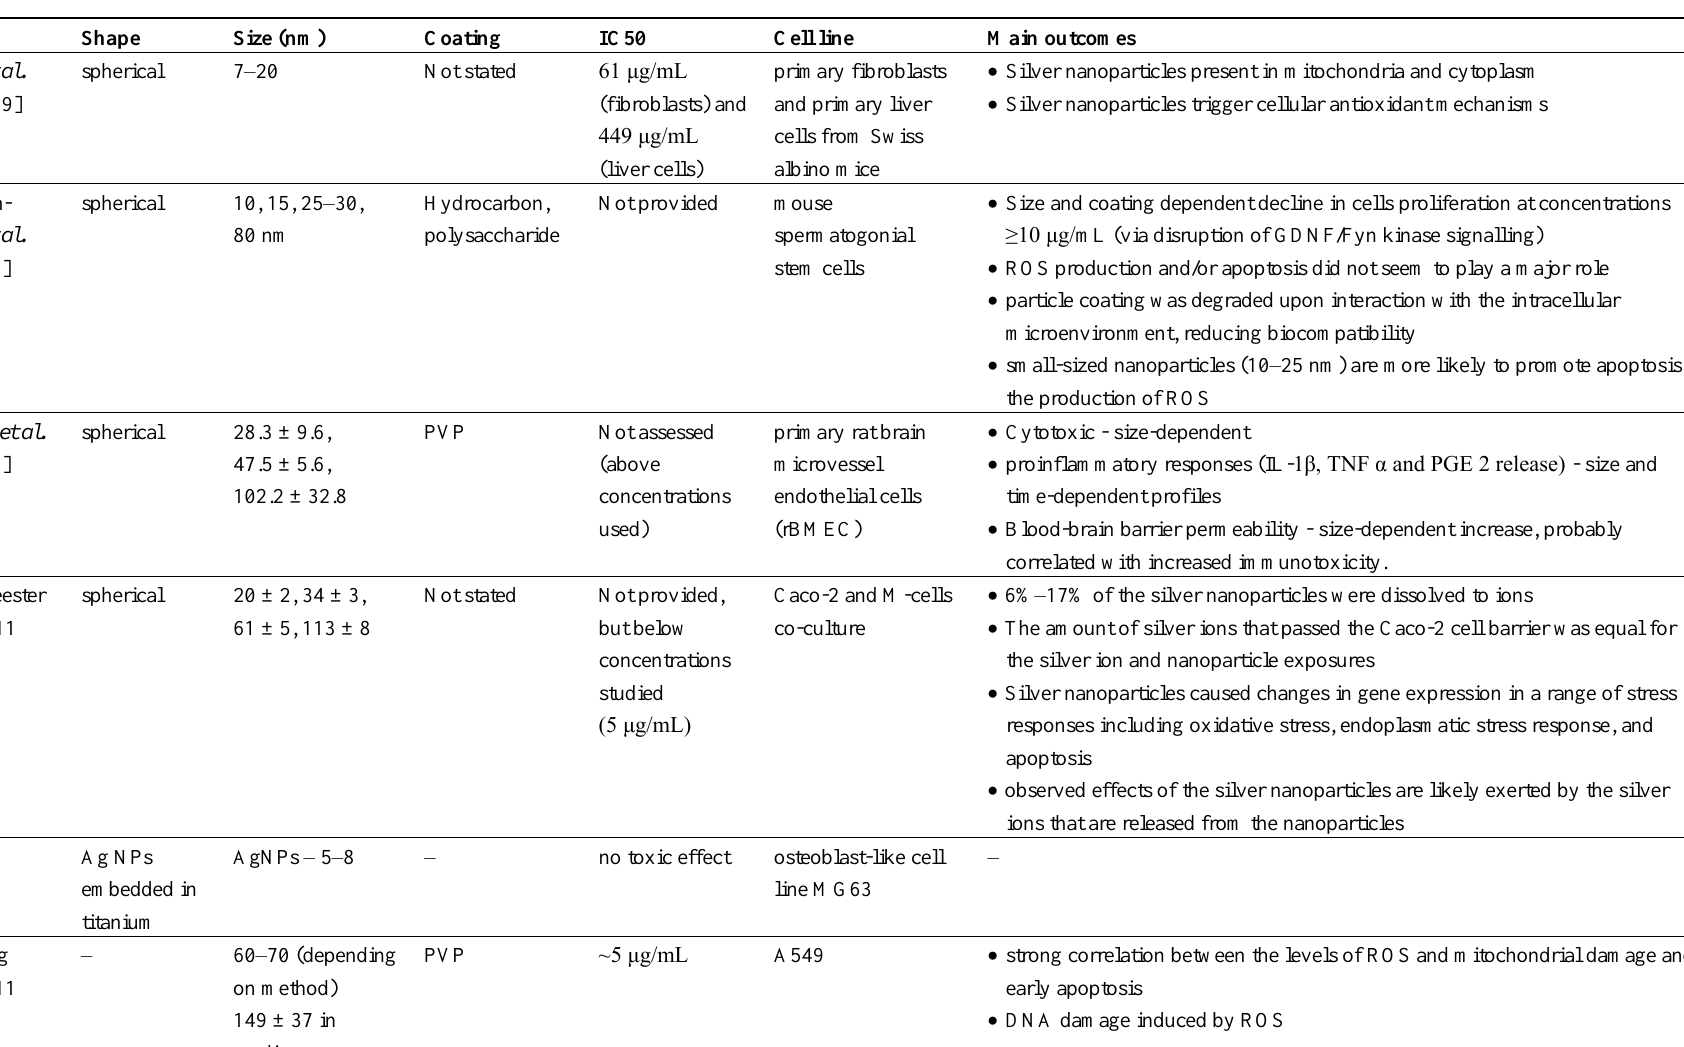
Table A3. Silver nanoparticles used in in vitro biological experiments and their